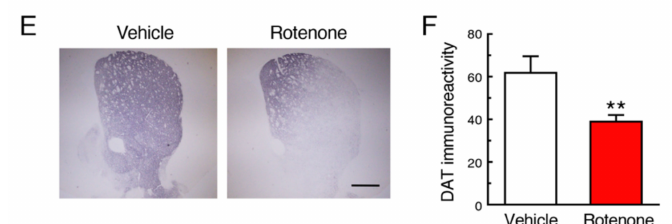
Figure2. Chronicexposuretolow-doserotenoneinducednigrostriataldopaminergicneurodegeneration in mice. ( A , C ) Representative photomicrographs of immunohistochemistry for tyrosine hydroxylase (TH) in the substantia nigra pars compacta (SNpc) ( A ) and striatum ( C ) of mice 4 weeks after rotenone treatment. Scale bar = 200 µ m ( A ), 500 µ m ( C ). ( B ) Changes in the number of TH-positive nigral